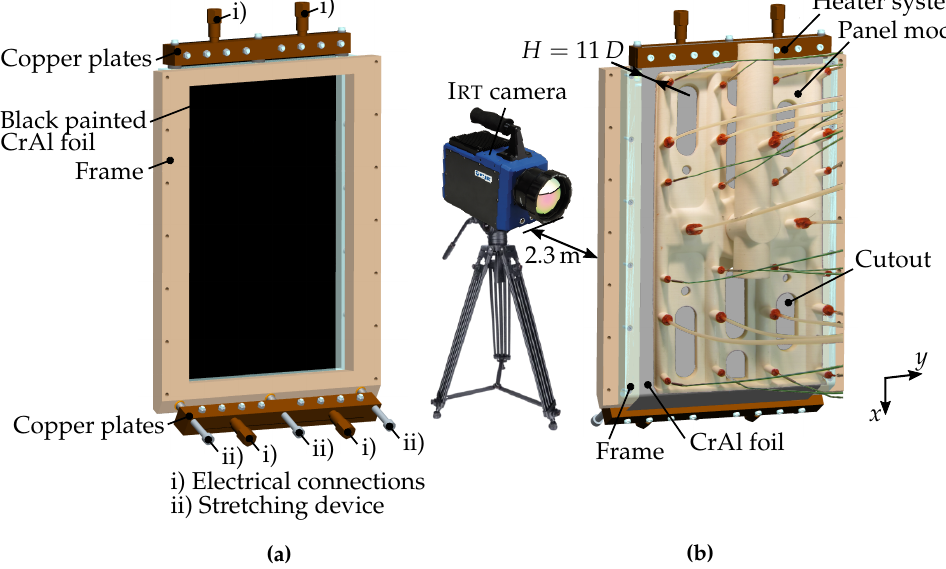
Figure 2. Heater system from an inside and outside view of the channel: ( a ) Backside view of target plate; ( b ) Schematic illustration of the positioning of panel model, heater system and IRT